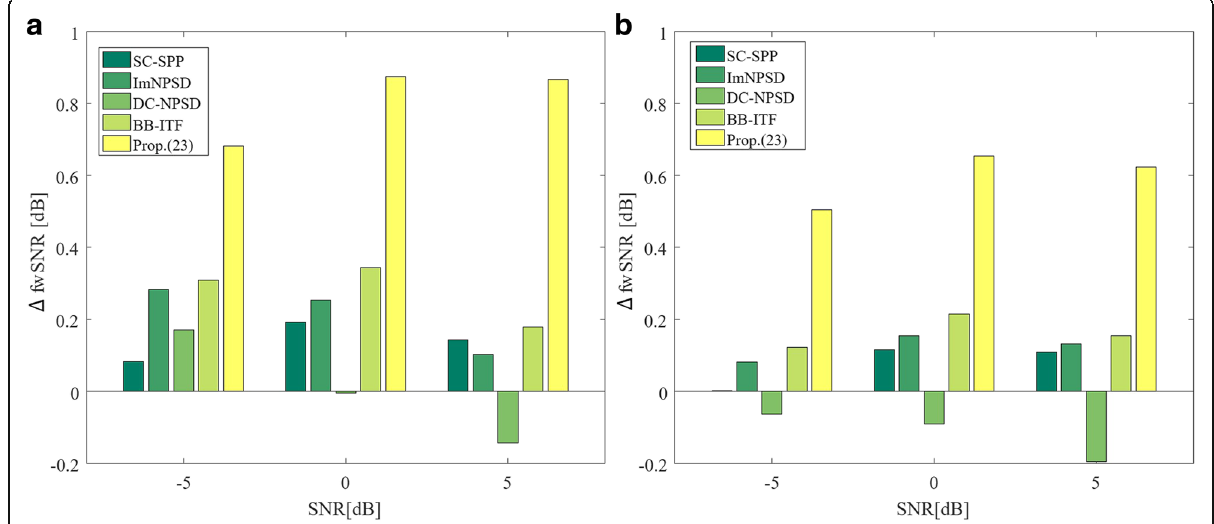
Fig. 11 Frequency-weighted SNR improvement results in the left channel: a speech source at 0 ° and b − 90°